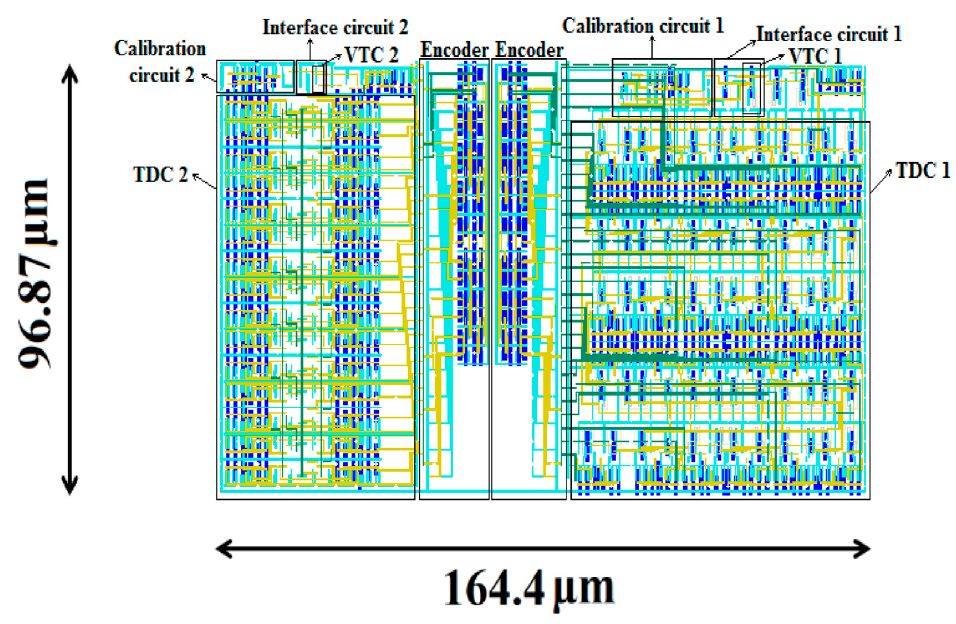
Figure 29. Layout of the two proposed ADCs.